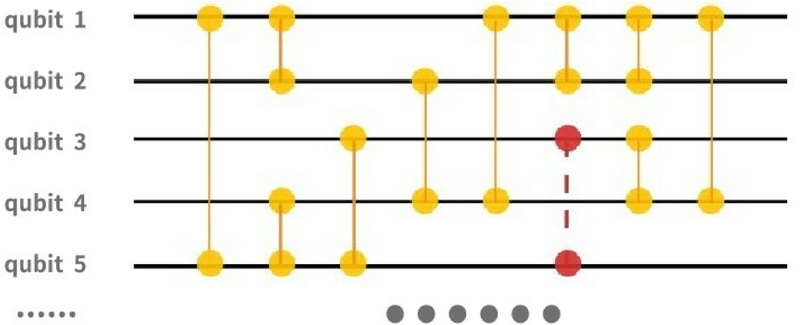
Figure 5 . This can be seen as the structure of holographic fluctuation which is composed of qubits (lines) and gates (connections between lines). The red part represents a fluctuation, that is, in a time-slice, a 2 -local gate is applied to an arbitrary pair of qubits followed by its